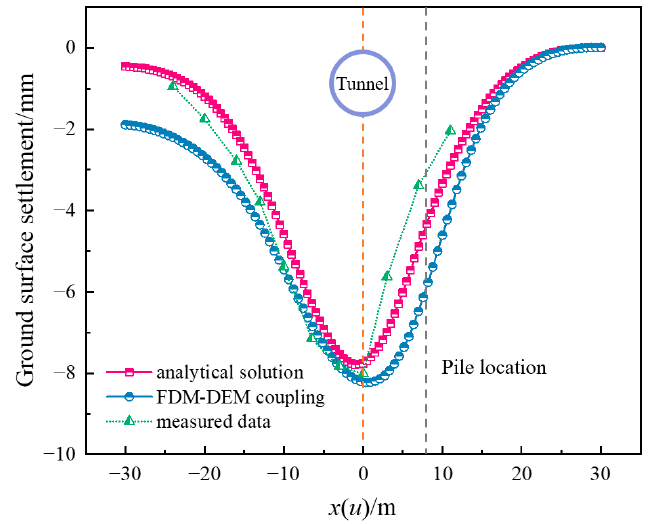
Figure 9. Comparison with field measured data.